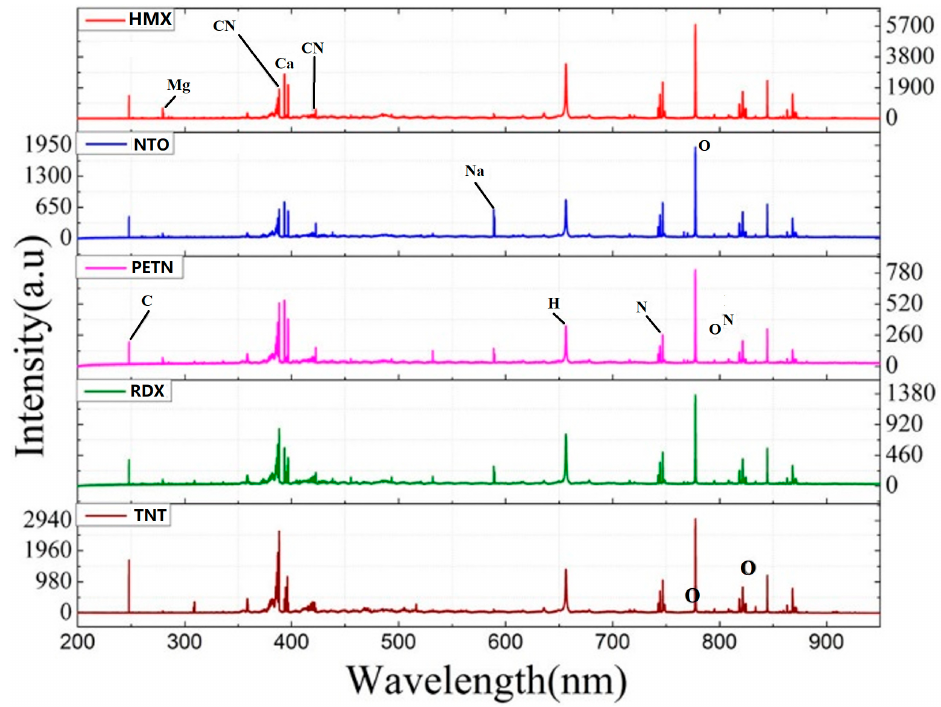
Figure 7. Representative LIBS spectra of typical explosives. Adapted from [98], with permission from © 2015 Springer Nature.